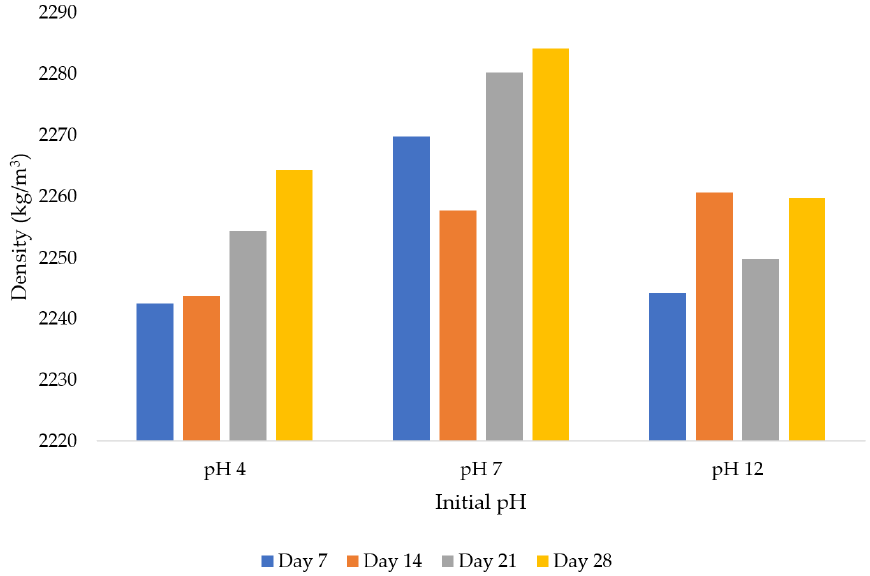
Figure 5. The density of the samples with time.